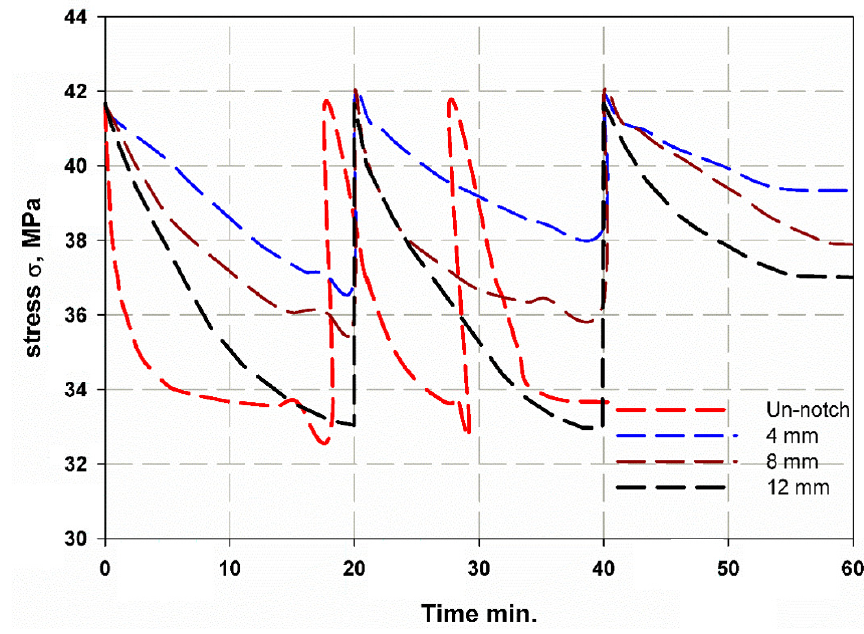
Figure 15. Relaxation stress and time curve of GFRP.